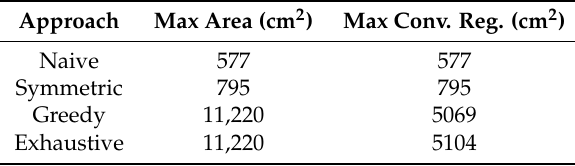
Table 3. Results of Maximal Convex Region Optimization on Surgical